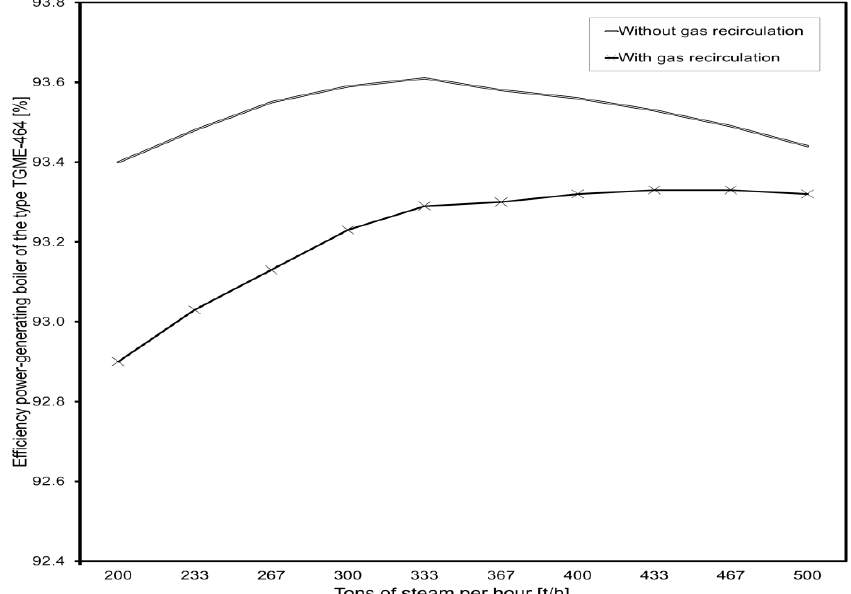
Figure 8. Influence of flue gas recirculation on the efficiency of a power boiler